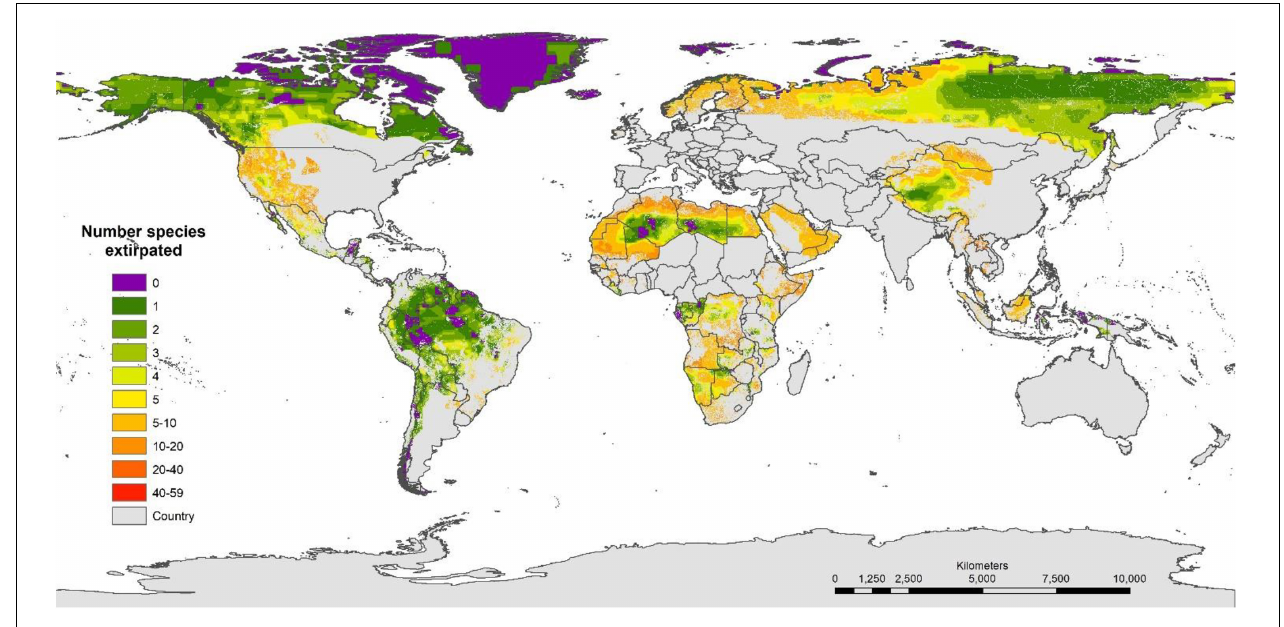
FIGURE 6 | The number of extirpated species (mammals and all other taxa mapped on the IUCN Red List) mapped in areas of habitat intactness (Human Footprint ≤ 4) for the land surface of the earth (removing areas (gray) where species have become globally extinct since 1500 AD, HF > 4, and Antarctica).